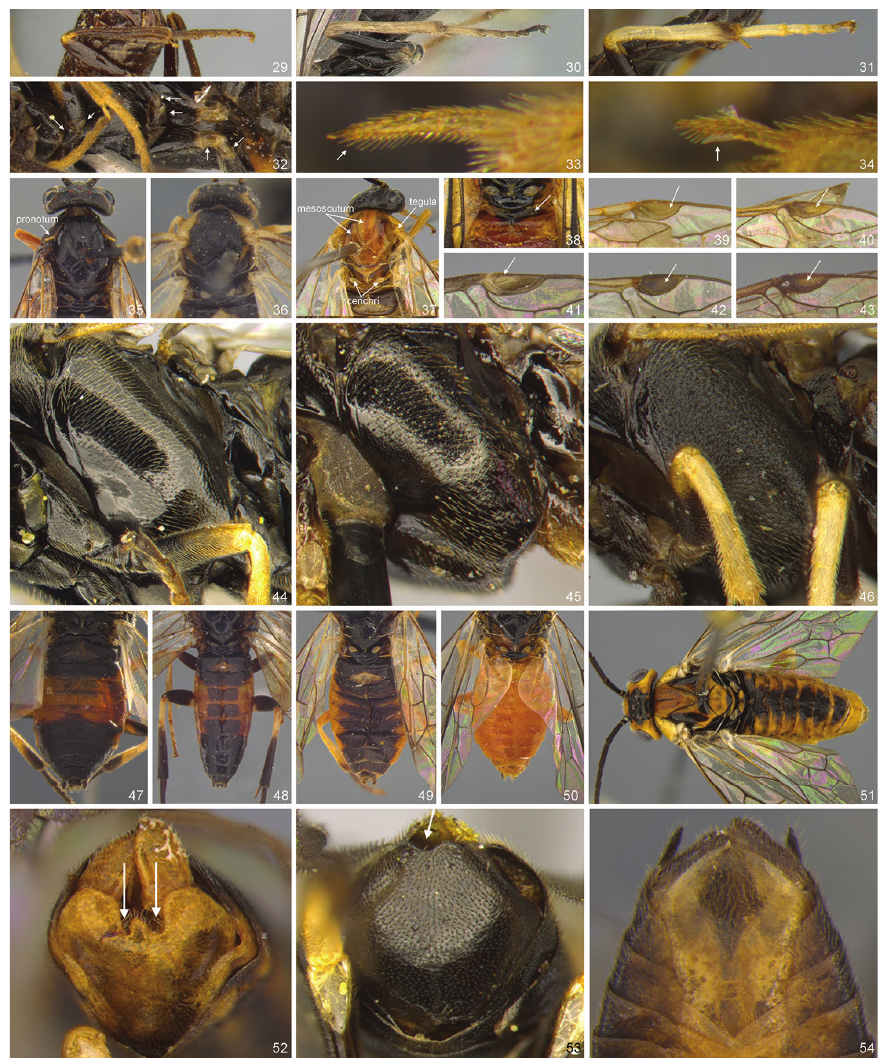
Figures 29–54. External characters used to identify Pristiphora species. 29 atripes holotype 30 malaisei DEI-GISHym10991 31 pseudogeniculata DEI-GISHym20832 32 pusilla DEI-GISHym80050 (arrows indicate trochanters and trochantelli) 33 friesei DEI-GISHym31524 (arrow indicates hair and the absence of velum on anterior protibial spur) 34 nigella DEI-GISHym31549 (arrow indicates the velum) 35 erichsonii DEI-GISHym20807 36 paralella 15-255 37 nigriceps DEI-GISHym31687 38 subbifida DEI- GISHym11332 (arrow indicates partly pale metapostnotum) 39 subopaca holotype, pterostigma (arrow) 40 opaca holotype 41 retusa DEI-GISHym31584 42 ruficornis DEI-GISHym31185 43 conjugata DEI- GISHym20960 44 albitibia DEI-GISHym31514, thorax in lateral view 45 luteipes DEI-GISHym80038 46 astragali holotype 47 cincta DEI-GISHym31501 48 condei DEI-GISHym20957 49 conjugata DEI- GISHym20960 50 testacea DEI-GISHym31237 51 cadma TUZ615726 52 biscalis DEI-GISHym80224 (arrows indicate a deep notch at the posterior margin of sternum 9) 53 nigriceps DEI-GISHym80059 (arrow indicates a notch at the posterior margin of sternum 9) 54 pallidiventris